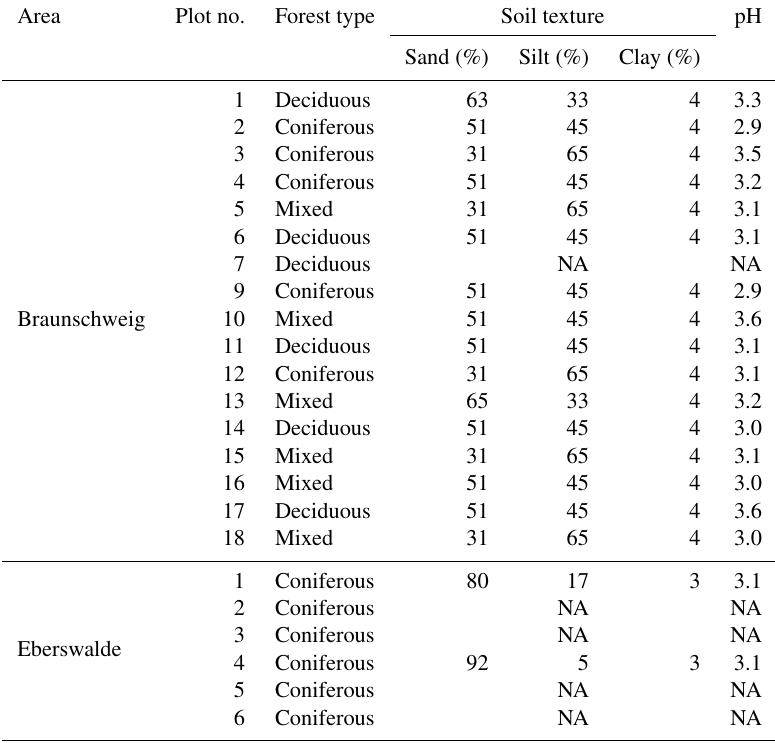
Table 1. Forest type, soil texture and soil pH in the plots at the Braunschweig ( n = 17) and Eberswalde ( n = 6) experimental sites. Area Plot no. Forest